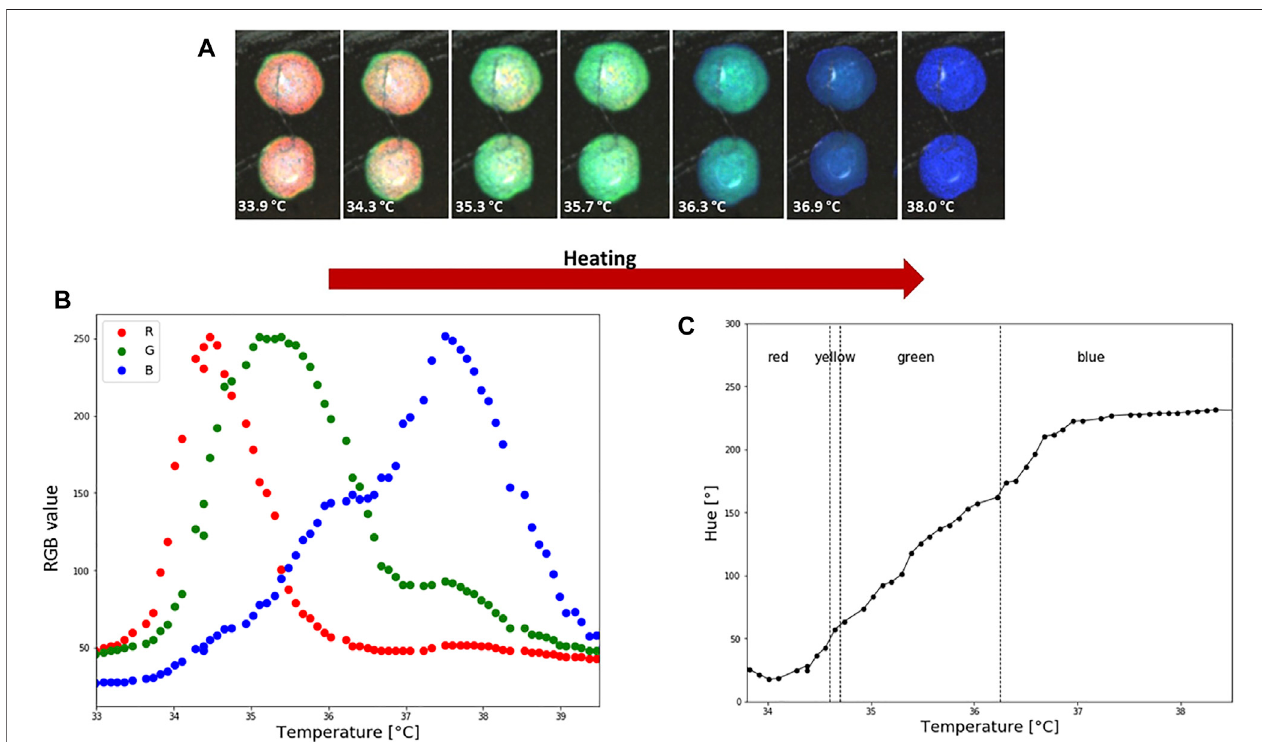
FIGURE 5 | LC2 patch colorimetric response during heating and calibration. (A) How the temperature is increasing LC are going through an optical active range, whichstartswithredand fi nisheswithbluecolour.AverageRGBandHSVvaluesfromtwospotswereusedtocreateacalibrationcurve.Eachspotis50×50pixels. (B) Temperature and RGB dependence. (C) Hue-temperature calibration curve. During the calibration the ambient temperature was 23 ° C and relative humidity 45%.